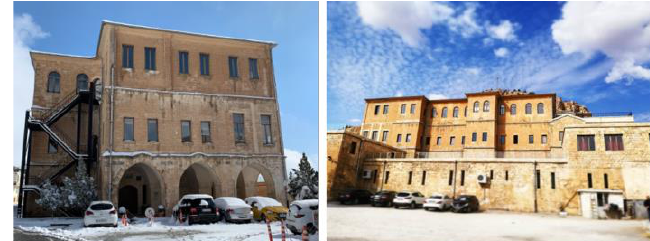
Fig. 10. Views of Mardin Artuklu University Faculty of